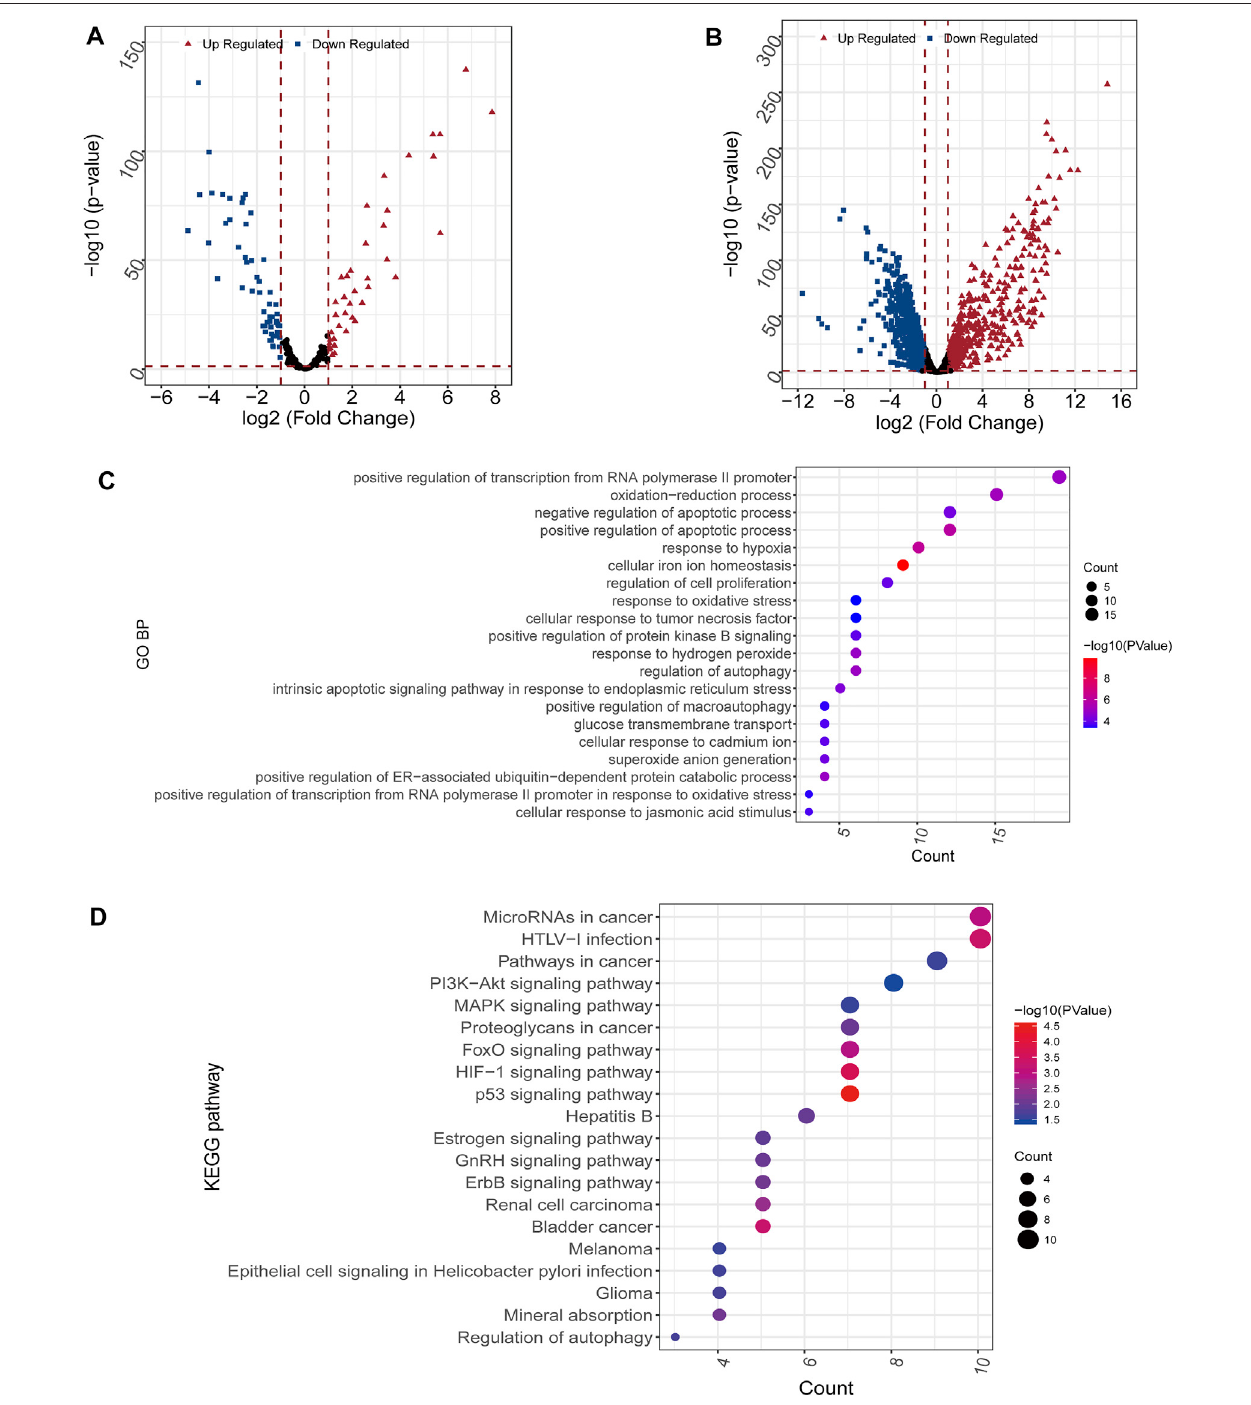
FIGURE2| Differentialandenrichmentanalysis (A,B) VolcanomapofdifferentiallyexpressedmRNAs (A) andlncRNAs (B) .Redtriangle:upregulated;bluesquare: down regulated (C) GOanalysis.The color scalerepresented p value and the circle sizeindicated count (D) KEGG analysis. The colorscalerepresented p value and the circle size indicated